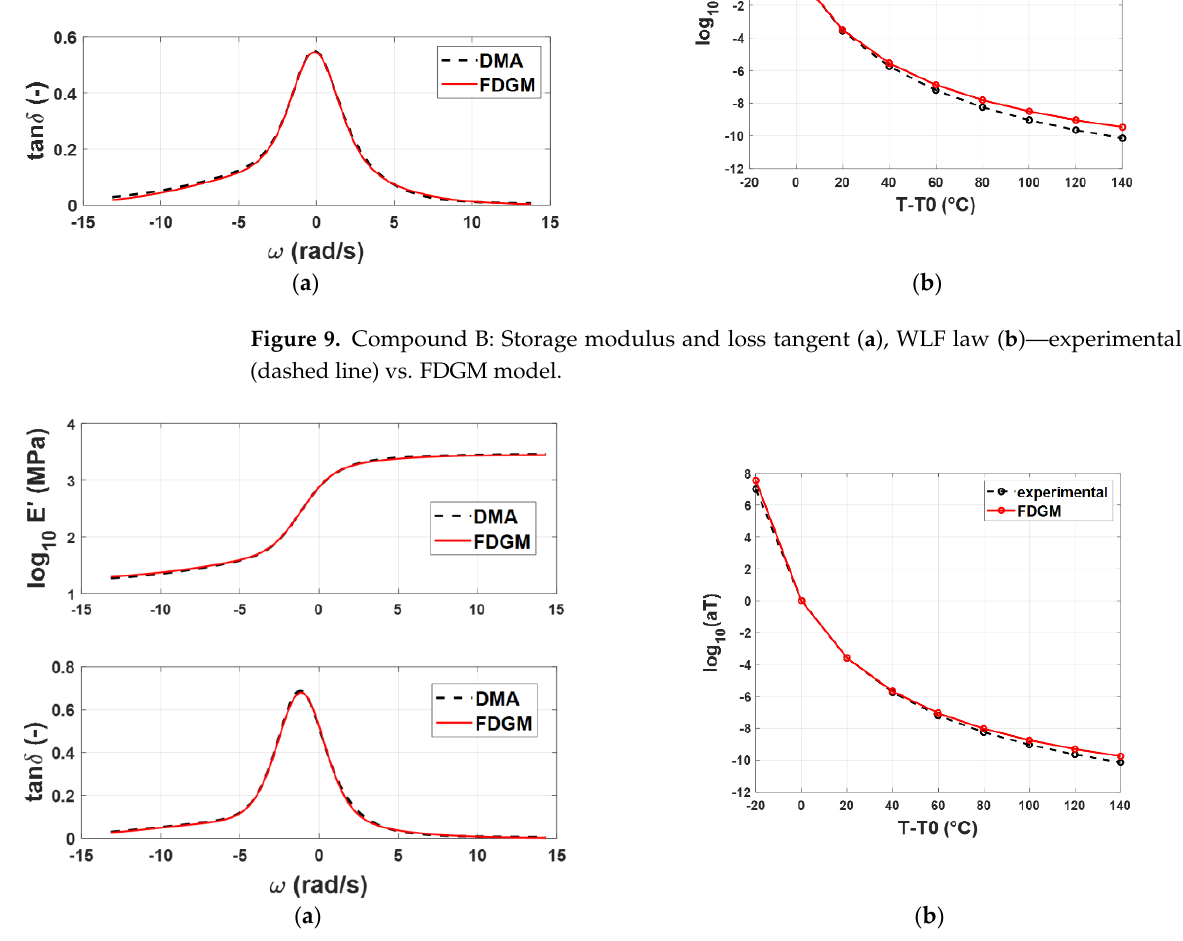
Figure 10. Compound C: Storage modulus and loss tangent ( a ), WLF law ( b ) — experimental data (dashed line) vs. FDGM model.